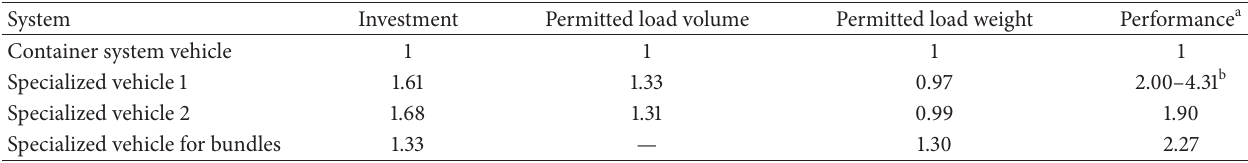
Table 4: Comparison of the observed vehicles according to level of investment, load volume, load weight, and